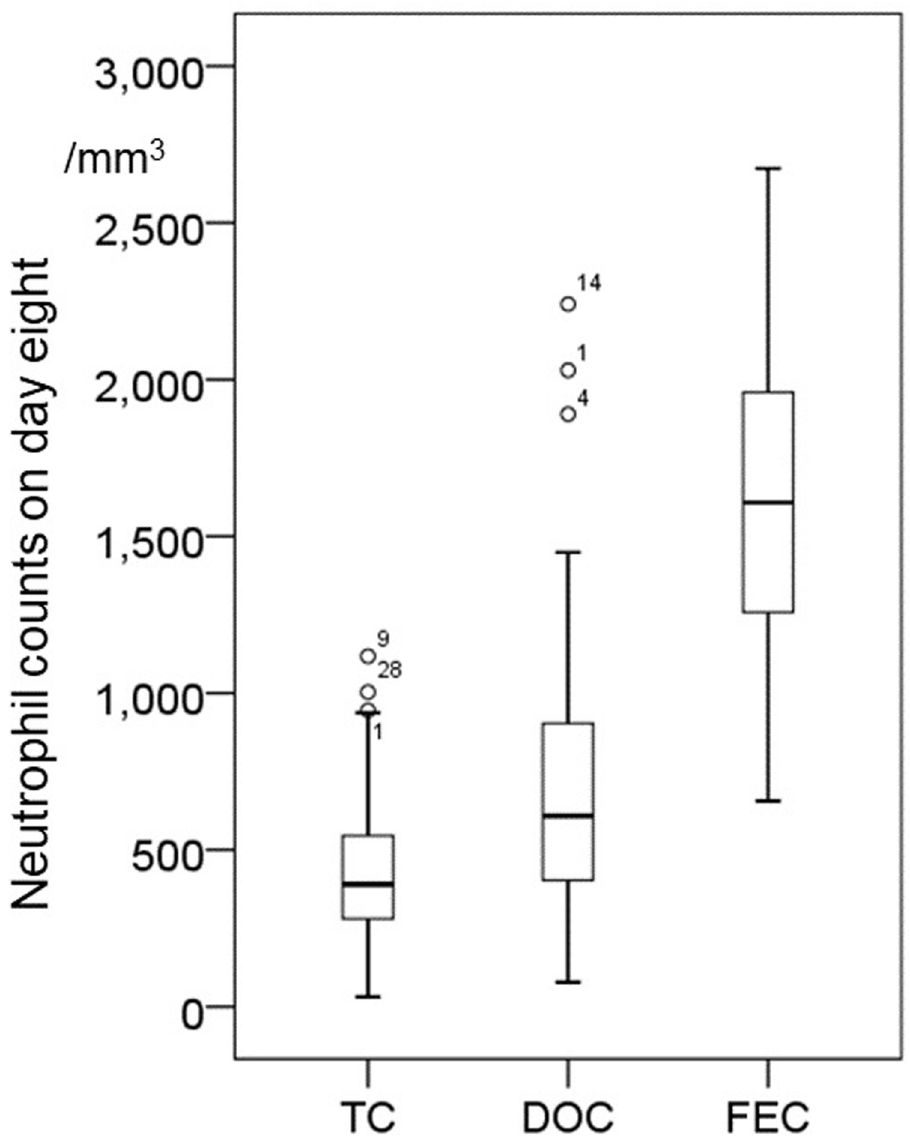
Fig 1. Absolute neutrophil count on day 8 in TC, DOC and FEC-treated patients. Box-plot diagram of absolute neutrophil count on day 8 in TC-treated, DOC-treated and FEC-treated